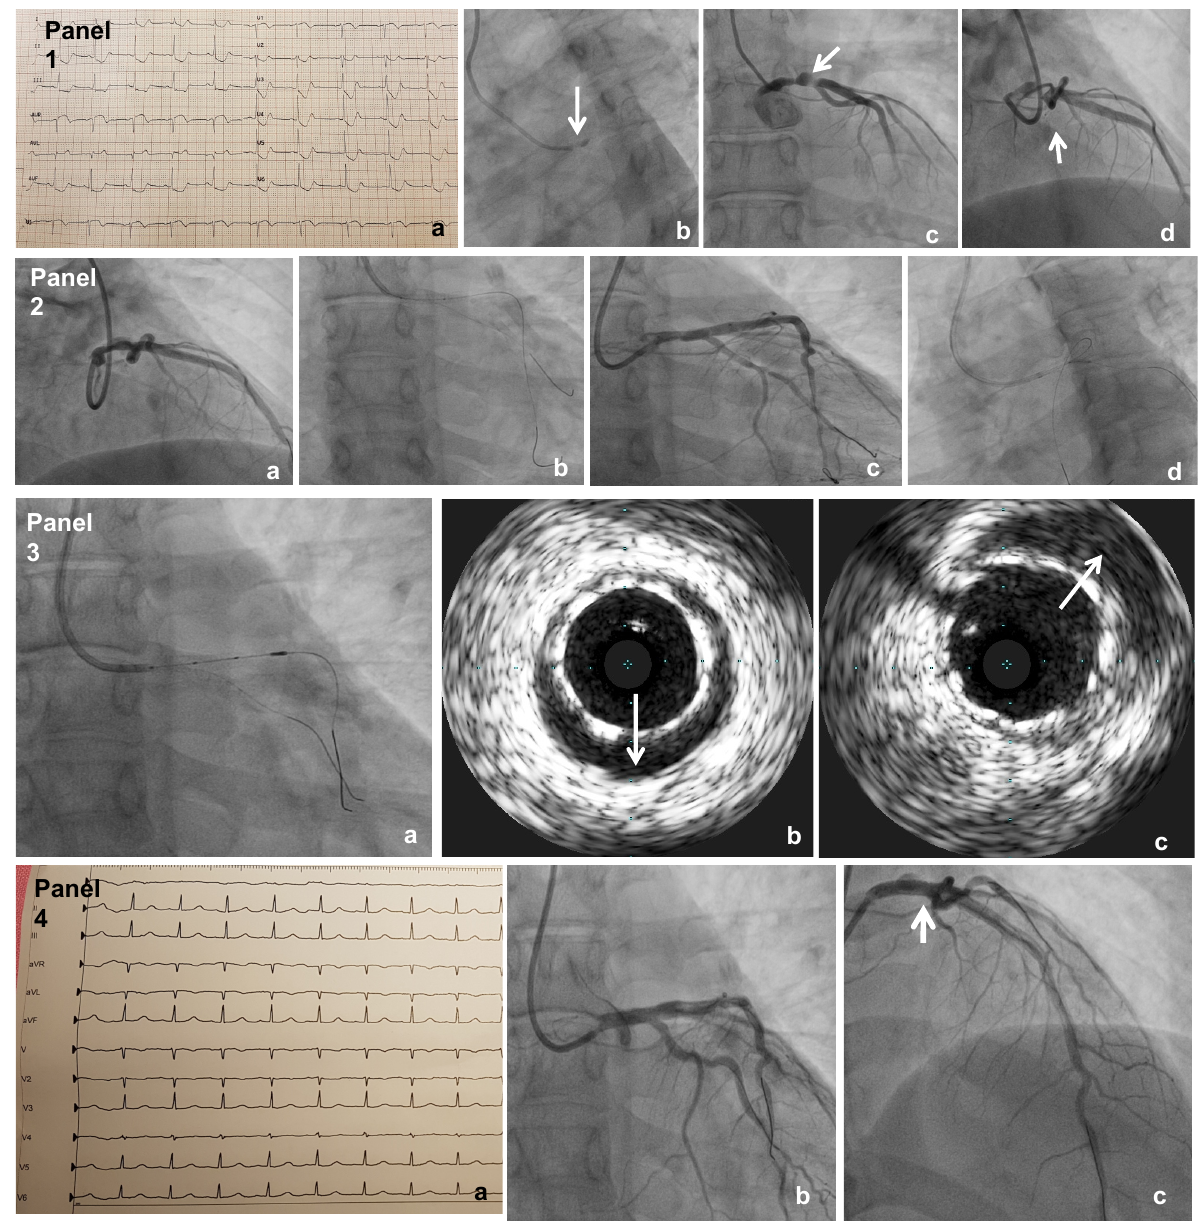
Figure 1. Panel 1 (a): ECG before coronary angiography showing diffuse anterior ischemic changes; (b): basal coronary angiogram with indirect signs of left main intramural hematoma with low contrast media injection in the aortic root; (c): left main sub-occlusion due to compression of intramural hematoma; (d): dissection with residual true lumen involving ostium of the anterior descending artery (white arrows). Panel 2 . Step by step procedure. (a): double wiring with balance middle weight into the circumflex and anterior descending artery; (b): stenting with Xience Pro 4 × 23 mm into LM-LAD system; (c): rewiring with Pilot 50 into CX and post-expansion with 4.5 × 15 mm non- compliant balloon Accuforce; (d): lateral kissing with 2 × 10 mm Euphora. Panel 3 . Intra-procedural intravascular ultrasound assessment (Volcano Corporation) (a): catheter manipulation into LAD-LM before and after balloon dilatations; (b): residual malposition after direct stenting; (c): good stent strut apposition and persistence of intramural hematoma after high pressure non-compliant balloon post-expansion. (white arrows) Panel 4 (a) ECG with regression of ischeamic changes after procedures, (b,c): Final coronary angiograms showing the restoration of normal flow and persistence of residual intramural hematoma (white arrow in